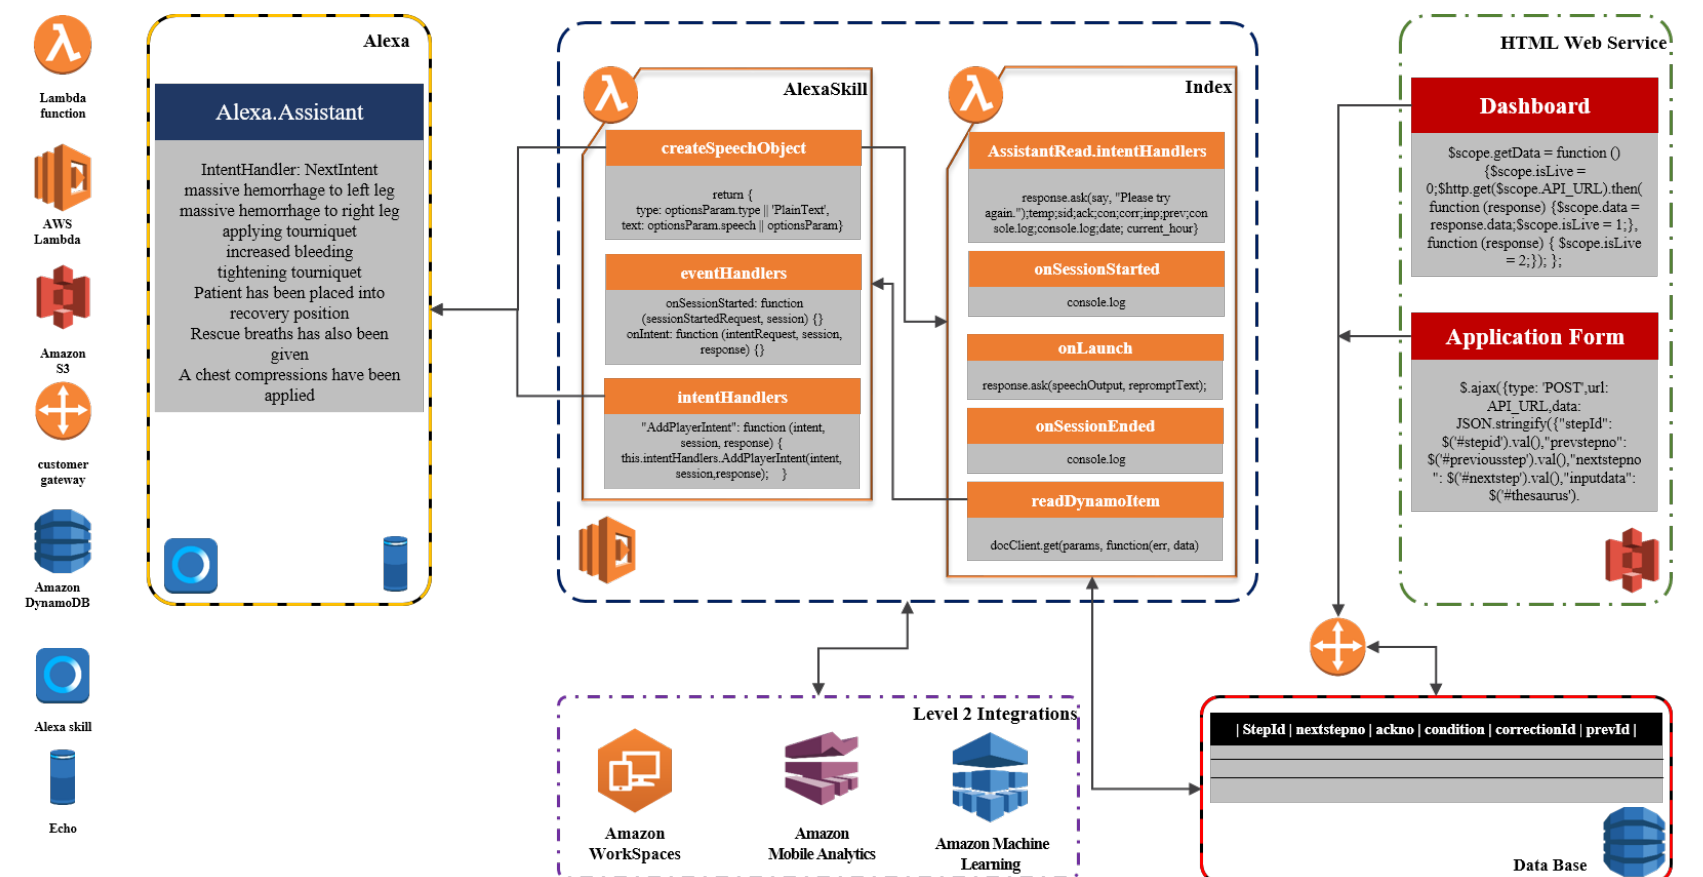
Figure 5. Unified Modeling Language (UML) diagram depicting the Amazon Web Services (AWS) architecture of VBSA (reproduced from